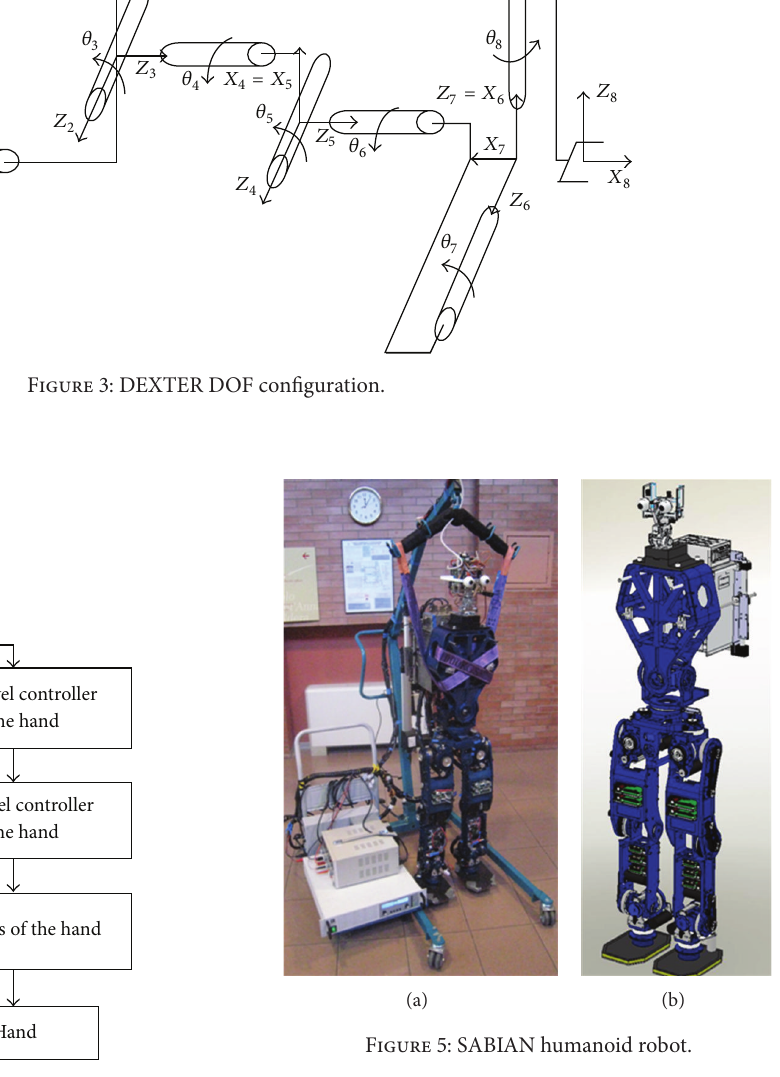
Figure 4: Functional architecture of the DEXTER manipulator system.